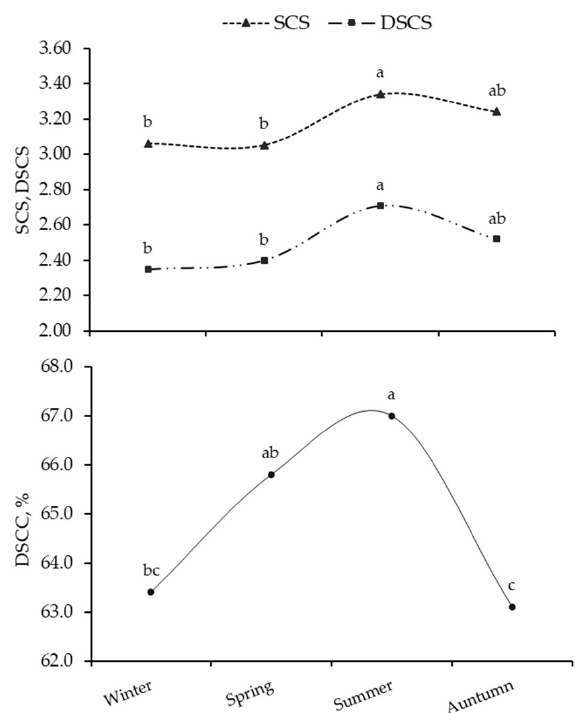
Figure 4. Least squares means of udder health traits across seasons of sampling. SCS, somatic cell score; DSCC, combined proportion (%) of polymorphonuclear neutrophils and lymphocytes out of the total somatic cell count (cells/mL); DSCS, log2-transformation of number of polymorphonuclear neutrophils and lymphocytes in milk (cells/mL). Values with different superscripts within udder health trait are significantly different ( p ≤ 0.05).